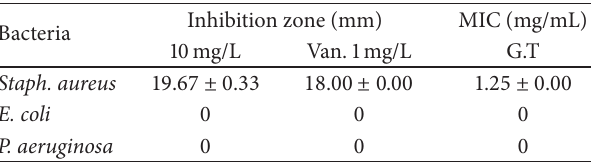
Table 2: Detection of MIC (mg/mL) of methanolic extract of Camellia sinensis by using MRSA (wound) species ( 𝑛 = 3